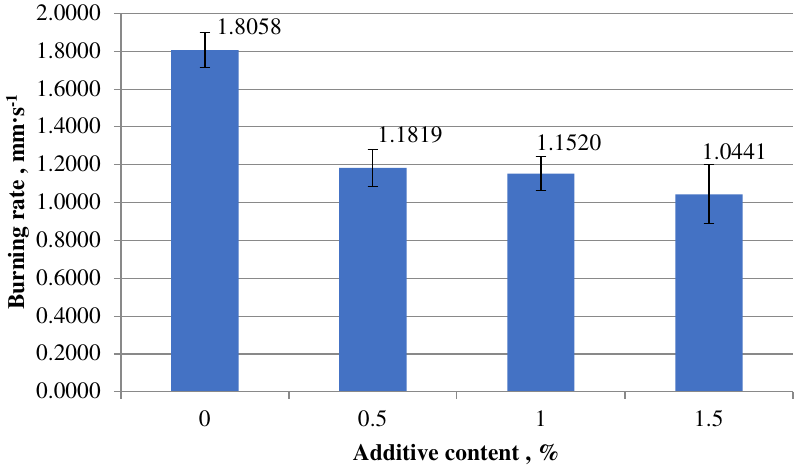
Figure 5. Influence of 6 on the burning rate of mixed potassium perchlorate/aluminum.